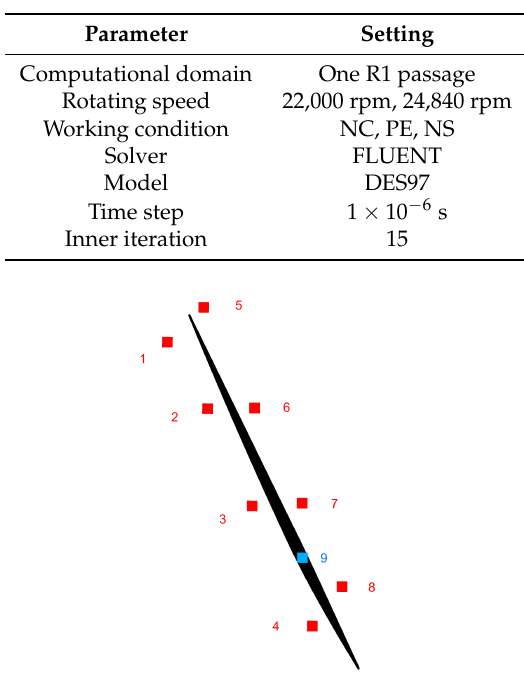
Table 2. Calculation settings.